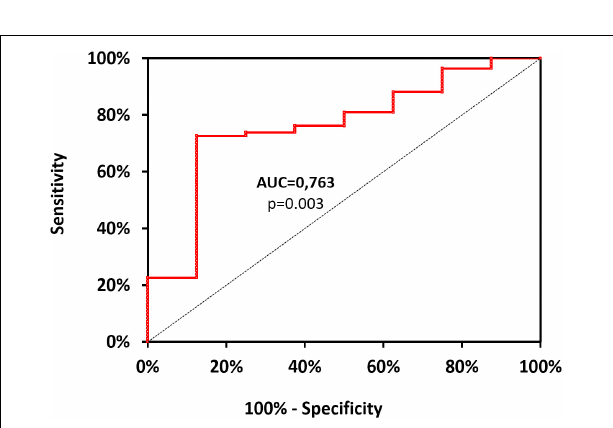
FIGURE 2 | Receiver operating characteristic curve for mtDNA values. It is designed from data including lonely divers ( n = 92), Ctrl+ being asymptomatic and therefore used as negative event. Positive events include Medullary Vestibular and Cerebro-Medullary DCS. The threshold value of mtDNA, highly predictive of clinical symptoms was determined as > 16726.10 6 copy of mtDNA/ µ L, with corresponding values of sensitivity and specificity as